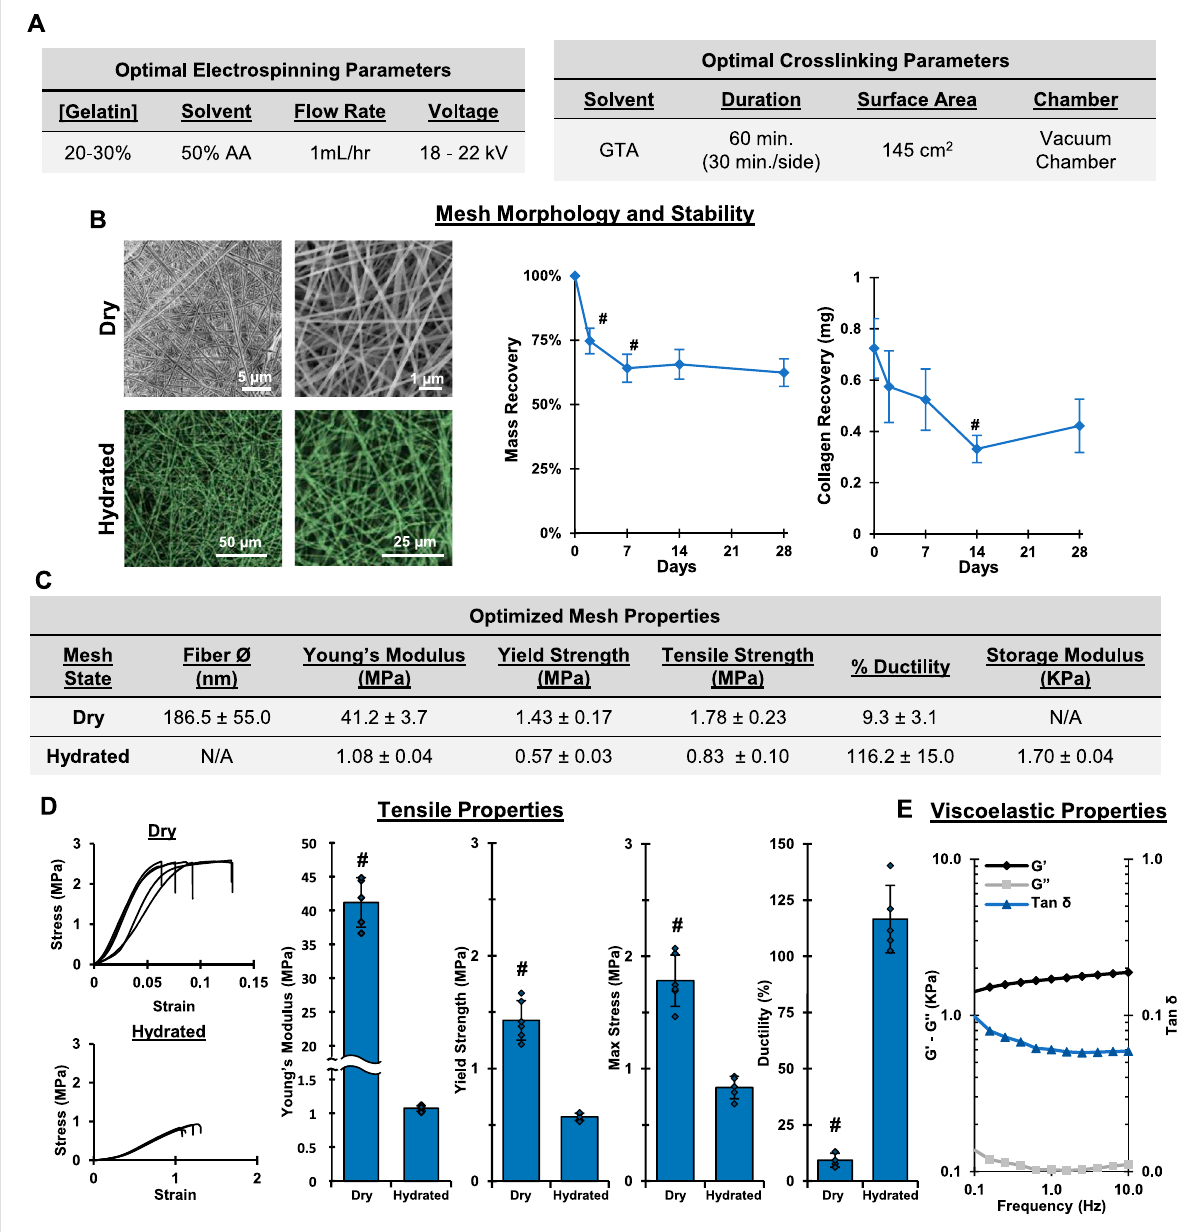
FIGURE 5 Optimal Fabrication: Electrospinning and Crosslinking. Gelatin electrospun in 50% acetic acid and crosslinked for 1 hr in a vacuum chamber results in stable, fi brous meshes with a conserved chemical composition. (A) Optimal electrospinning and crosslinking conditions. (B) Dry (SEM, 2,500x,10,000x) andwetmorphology(CRM,100x,300x)andstability ofcrosslinkedgelatin meshes preparedusingoptimizedparameters. (C) Table summarizing properties of optimized mesh. (D) Tensile properties after crosslinking and hydrating ( n = 10). (E) Viscoelastic properties of hydrated gelatin meshes ( n = 3). #= p <